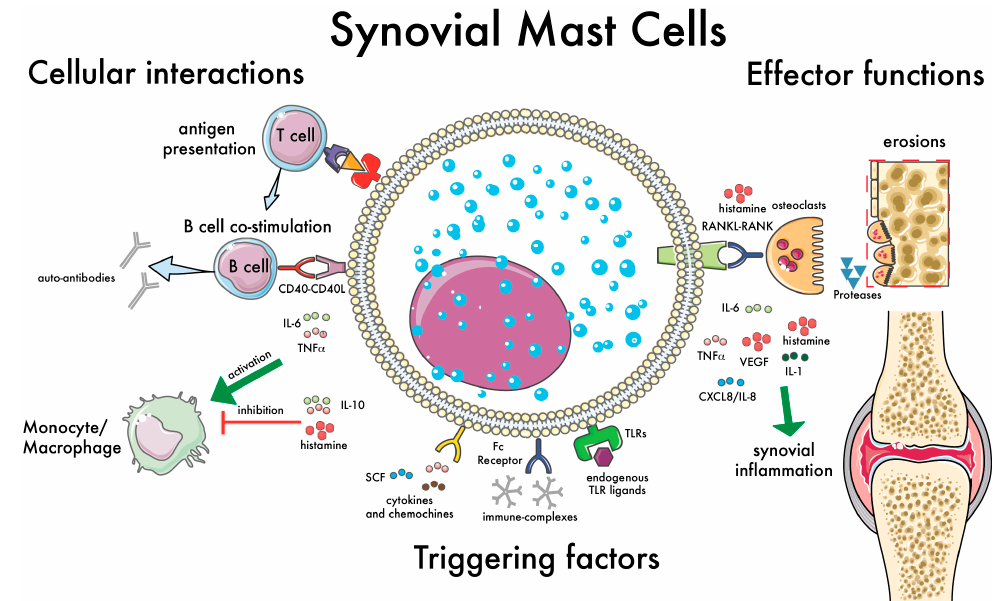
Figure 2. Synovial mast cell (MC): cellular interactions and effector functions. This illustration summarizes the main functions of synovial MCs with relevance in the pathogenesis of RA. Examples of factors capable of triggering MC activation are shown, such as immune complexes [54], cytokines and chemokines [50], and endogenous toll-like receptor (TLR) ligands [48]. The cellular interactions with immune cells are shown on the left: antigen presentation to T cells [55,56]; B cell co-stimulation via CD40–CD40L and soluble mediators (e.g., IL-6), inducing the production of auto-antibodies [31]; modulation of monocyte-macrophages activation [57]. Finally, on the right, the effector functions of MCs are summarized, with an emphasis on the induction of bone erosions, which can be mediated directly by MC-derived proteases [58] or indirectly via the activation of osteoclasts [59,60]. Green arrows indicate the effects of proinflammatory citokines; the “T” bar indicates the effects of antinflammatory citokines.